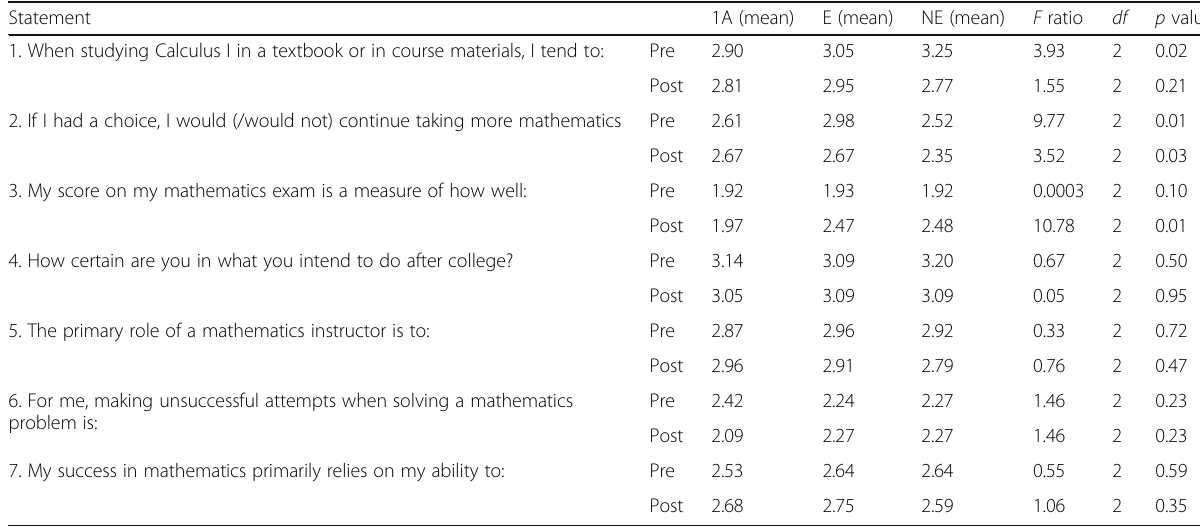
Table 5 Changes in sample means of students ’ beliefs and attitudes